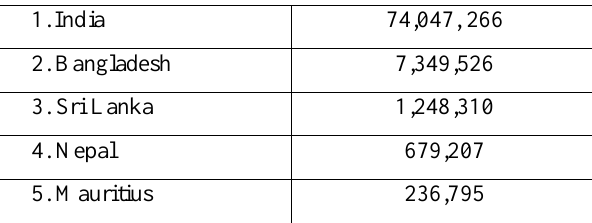
Table 1. Top 5 countries for the number of people with diabetes (18-99 years), 2017